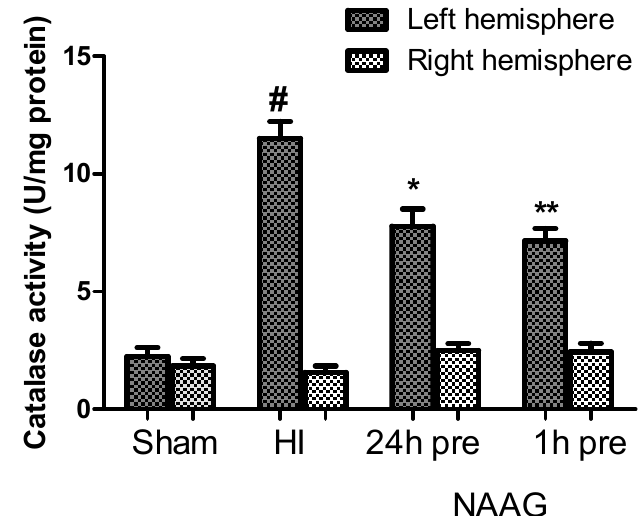
Figure 7. Effect of NAAG application on HI induced changes in catalase activity. The results are presented as the means ±SEM, n = 6; statistically significant differences: * p < 0.005, ** p < 0.001 compared to the HI group; # p < 0.001 compared to the sham operated group.